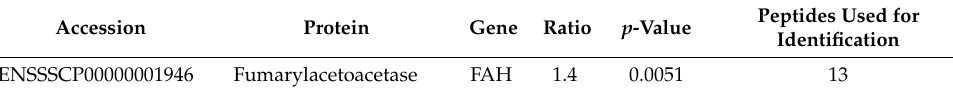
Table 4. Proteins from mass spectrometry dataset. Significantly ( p ≤ 0.01) differentially abundant proteins, quantified with more than 2 peptides in CD4 + PBMCs of GHR -KO pigs ( n = 4) compared to WT pigs ( n =